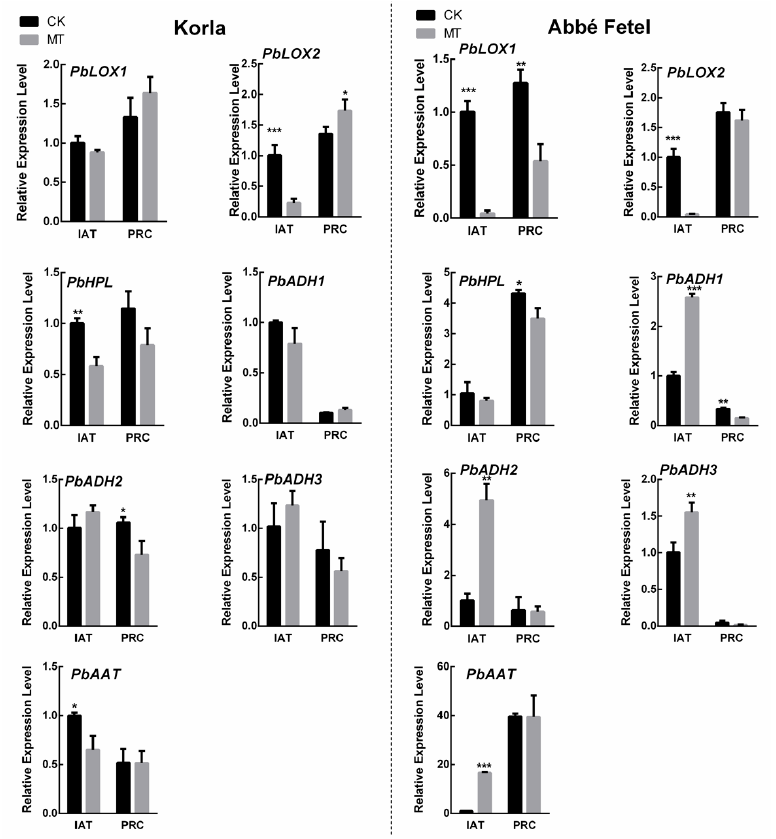
Figure 5. Effect of melatonin on relative expression of ester-related gene. Levels of gene expression at the first sampling point under control conditions was normalized as 1.0. Data are means ± SD of three replicates. * p < 0.05, ** p < 0.01, *** p <